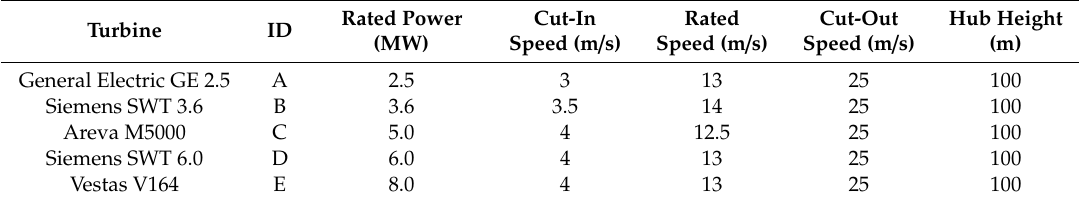
Table 2. Technical specifications of the selected wind turbines